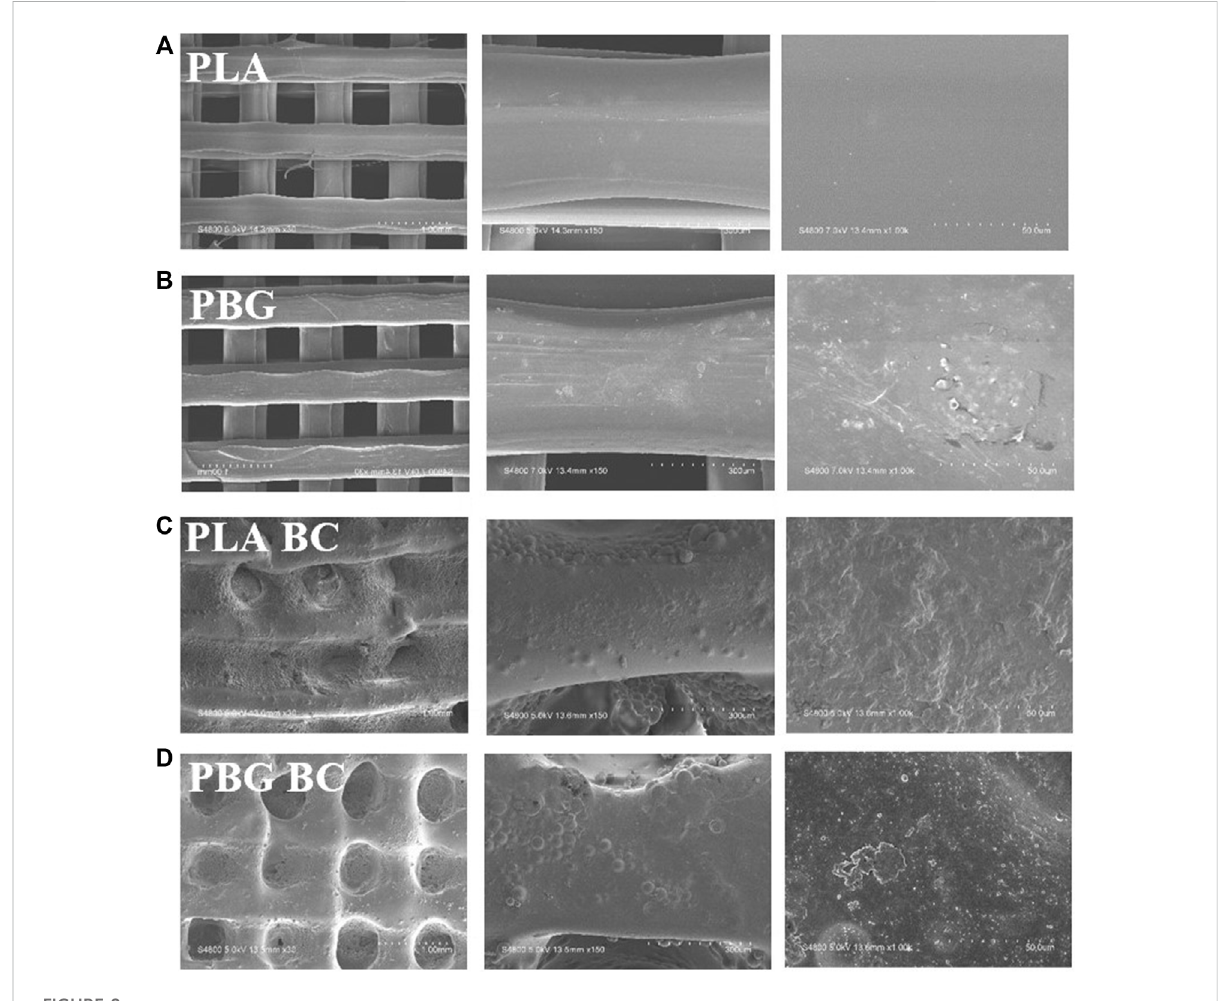
FIGURE 8 SEM of the scaffolds. (A) : PLA; (B) PBG; (C) PLA-BC; (D)